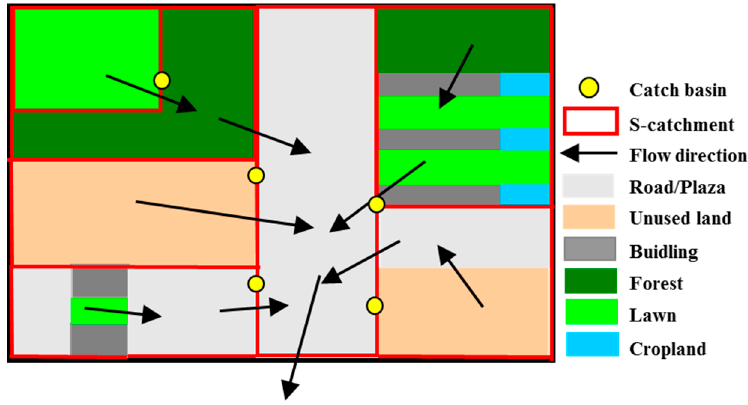
Figure 11. S-catchments and their upstream/downstream relationships.